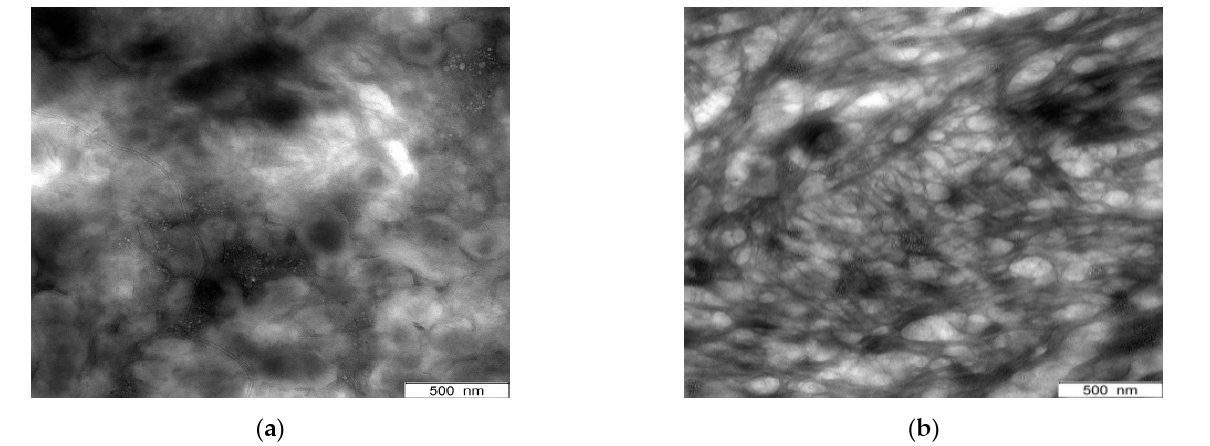
Figure 8. TEM images of CNTs pretreated with sodium dodecylbenzenesulfonate (SDBS). ( a ) for 10 min US and ( b ) 60 min US.